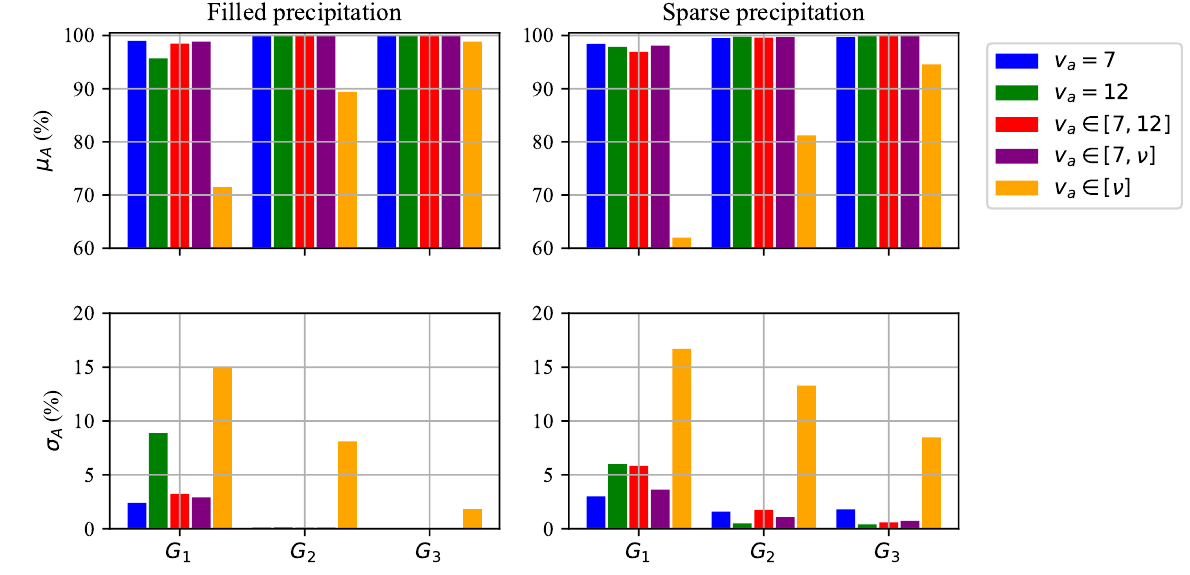
Figure 8. Comparisons of the trained CNN with different v a , i.e., v a = 7 ms − 1 (blue), v a = 12 ms − 1 (green), v a ∈ [ 7,12 ] (red), v a ∈ [ 7, ν ] (purple), and v a ∈ [ ν ] (orange) for each on the mostly filled precipitation ( left ), and the sparsely filled precipitation ( right